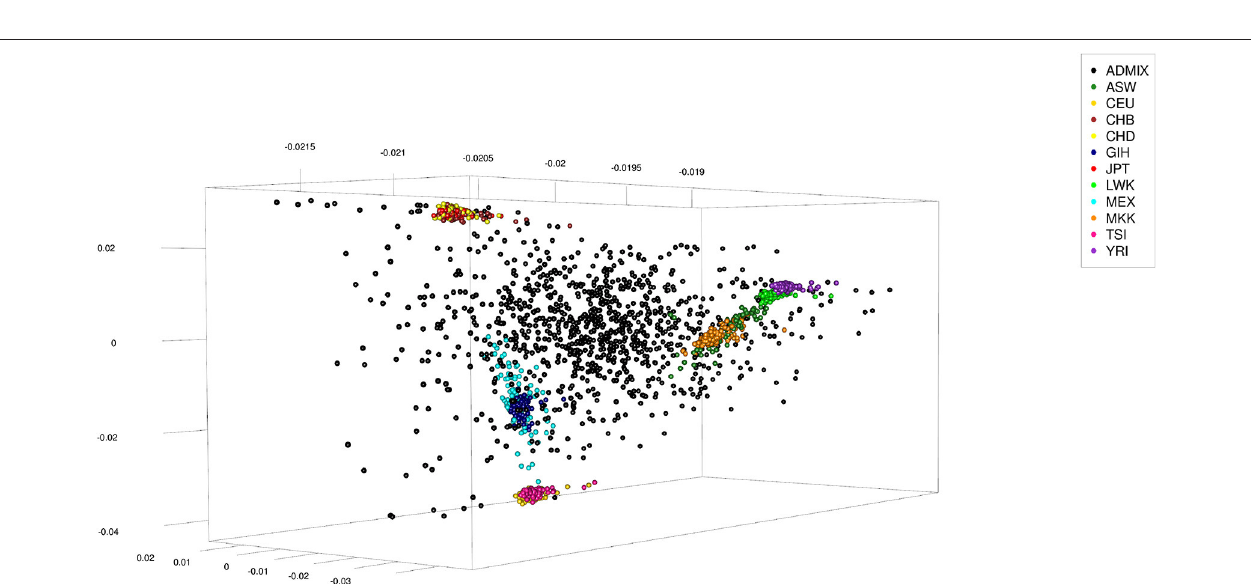
FIGURE 2 | First three principal components of artificially admixed (black spheres) and non-admixed (colored spheres) individuals of the Human data set obtained from a singular value decomposition of a genetic marker matrix of dimension 2,397 (number of genotypes) by 150,000 (number of markers). The genotype sample consisted of 1,000 artificially admixed and 1,397 original genotypes. The original genotypes of non-admixed individuals were obtained from the International Hapmap Project.